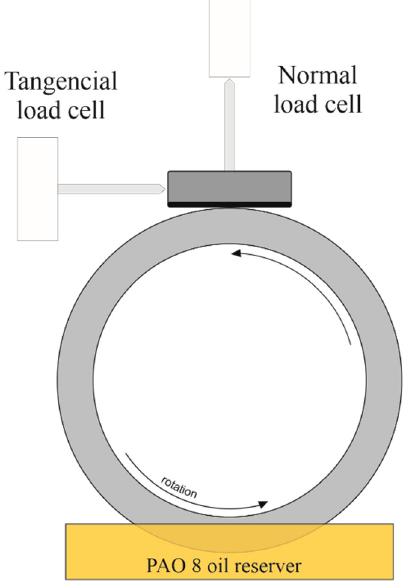
Figure 1. Schematic diagram of the block-on-ring sliding test tribometer.